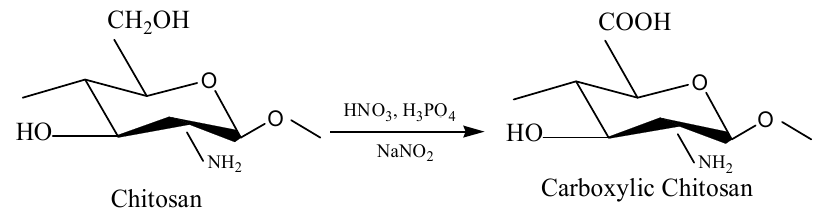
Figure 4. The schematic diagram of oxidization reaction of the chitosan.